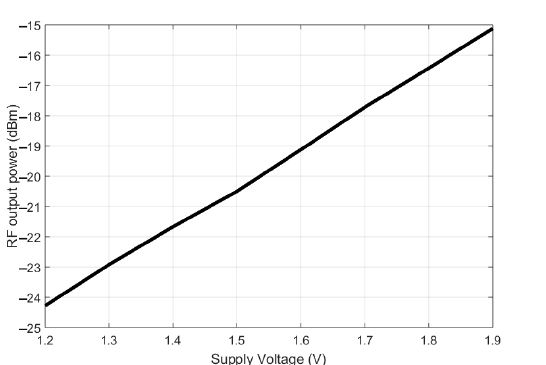
Figure 15. RF power versus voltage supply for the unoptimized IR-UWB Transmitter at 50 Mbps data rate vs supply voltage, with fixed 1 k Ω resistance for current